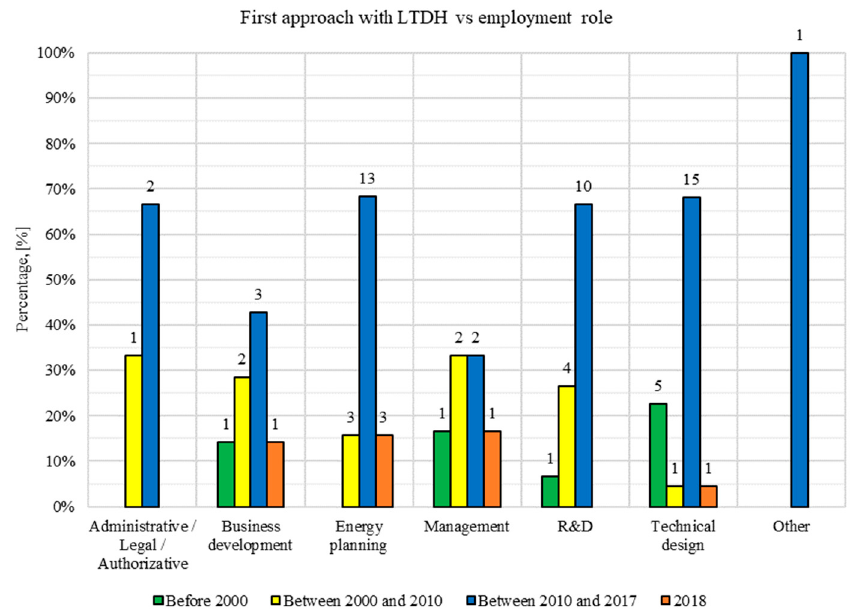
Figure 9. First exposure to the LTDH concept as a function of the role of the survey participants.